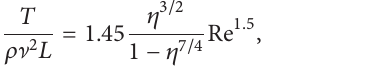
walls shears the fluid in the annular gap to resist the rotation of the inner cylinder. This resistance manifests itself as a pattern. The torque predicted by CFD from integrating the surface shear stress on the inner cylinder is 2.09 × 10 −5 Nm and 2.06 × 10 −5 Nm, respectively, for the test cases Γ =